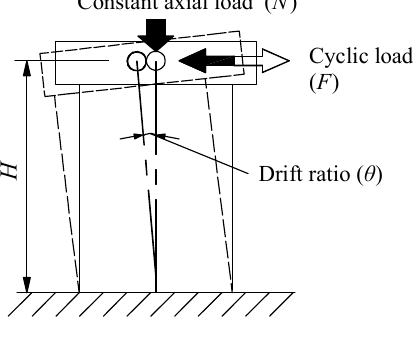
Figure 6. Definition of drift ratio θ .